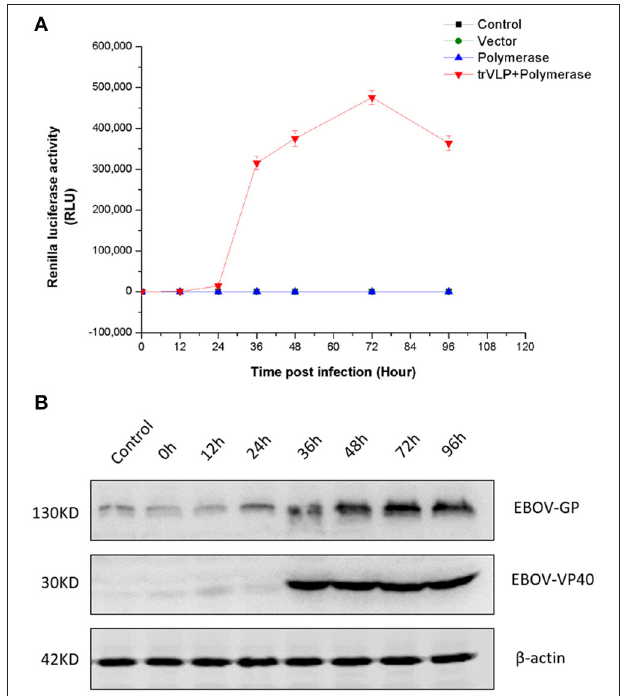
FIGURE 2 | Tetracistronic trVLP production in 293T cells. (A) Tetracistronic trVLP replication curve based on the detection of luciferase activity. In this experiment, P1 virus-like particles were used to infect target 293T cells (P1 cells) that had been transfected with helper plasmids (pCAGGS-NP, pCAGGS-VP35, pCAGGS-L, pCAGGS-VP30, pCAGGS-Tim-1) 1 day prior to infection, and there were three control groups (Control: transfected with only Transit LT1; Vector: transfected with empty pCAGGS; and Polymerase: transfected with pCAGGS-NP, pCAGGS-VP35, pCAGGS-L, pCAGGS-VP30, pCAGGS-Tim-1). Cell lysates were diluted 1:100 prior to the detection of luciferase activity, and each time point was measured in triplicate. The TCID 50 of P1 trVLPs was 10 − 6.5 /ml, and the inoculation volume was 2 ml/well in 6-well plates (4 × 10 5 cells/well). The results represent the mean ± SD of 3 different preparations. (B) Detection of viral protein expression. To investigate the expression of EBOV-GP and EBOV-VP40 by western blotting, we used a polyclonal antibody produced in horse against EBOV-GP or